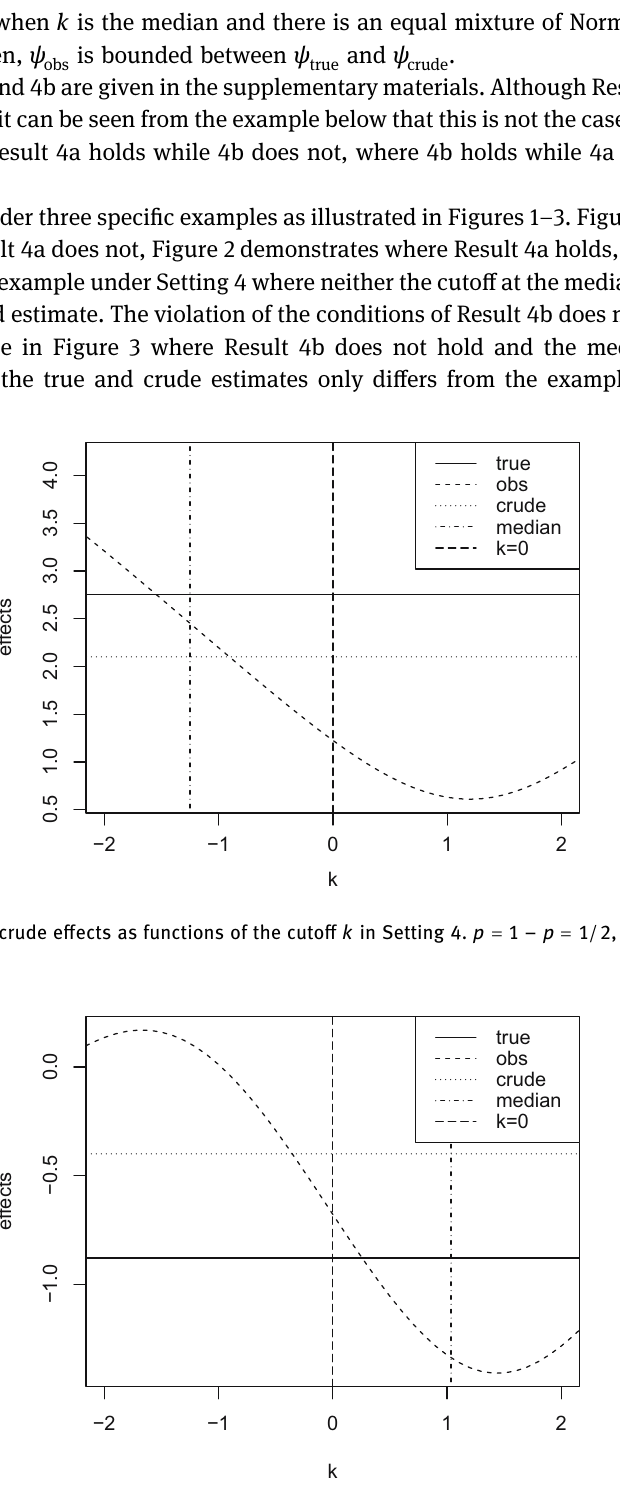
Figure 2: True, observed, and crude e ff ects as functions of the cuto ff k in Setting 4. p 0.6 = , μ −2 and δ −2.2 =